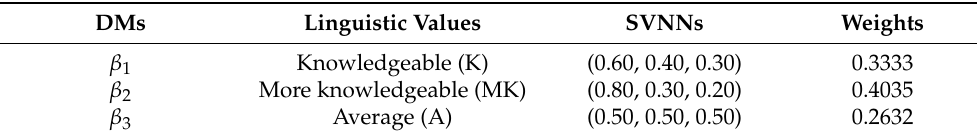
Table 6. Weights of the